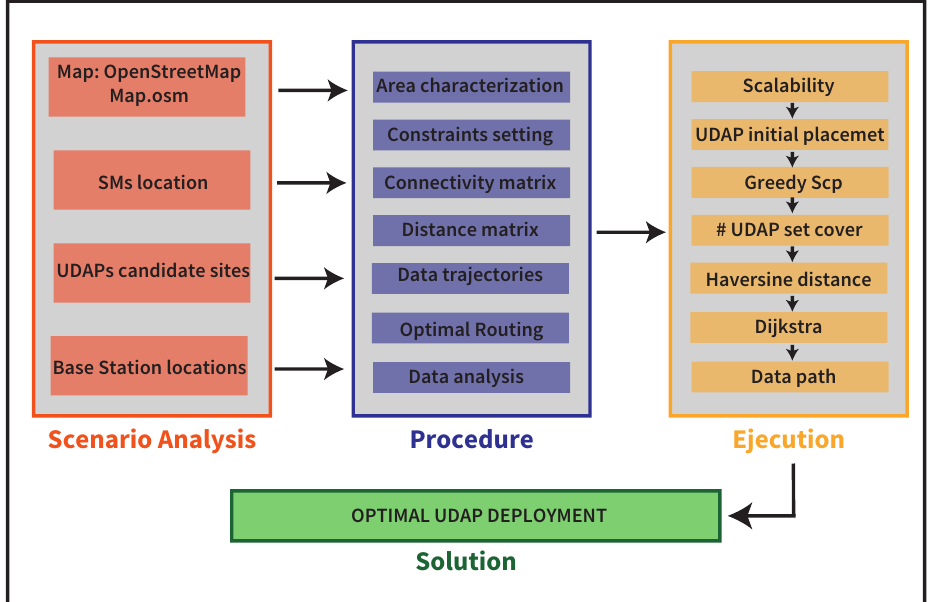
Figure 2. Methodological flowchart for the optimal UDAP